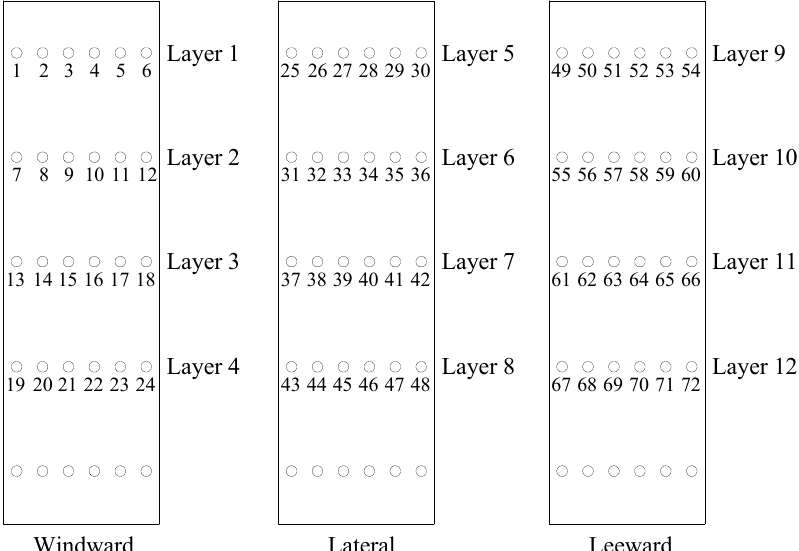
Table 1. The geometry size of the test